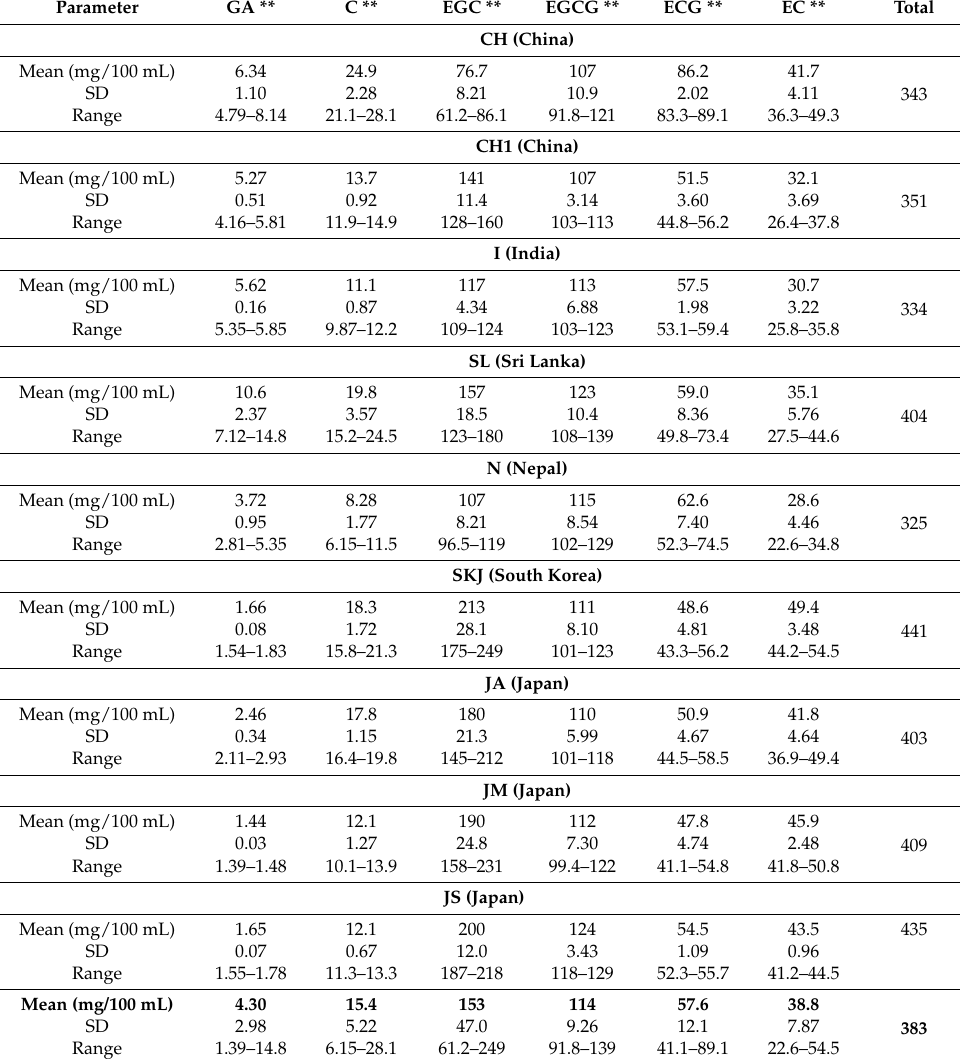
Table 6. Concentration of gallic acid and catechins in the green tea